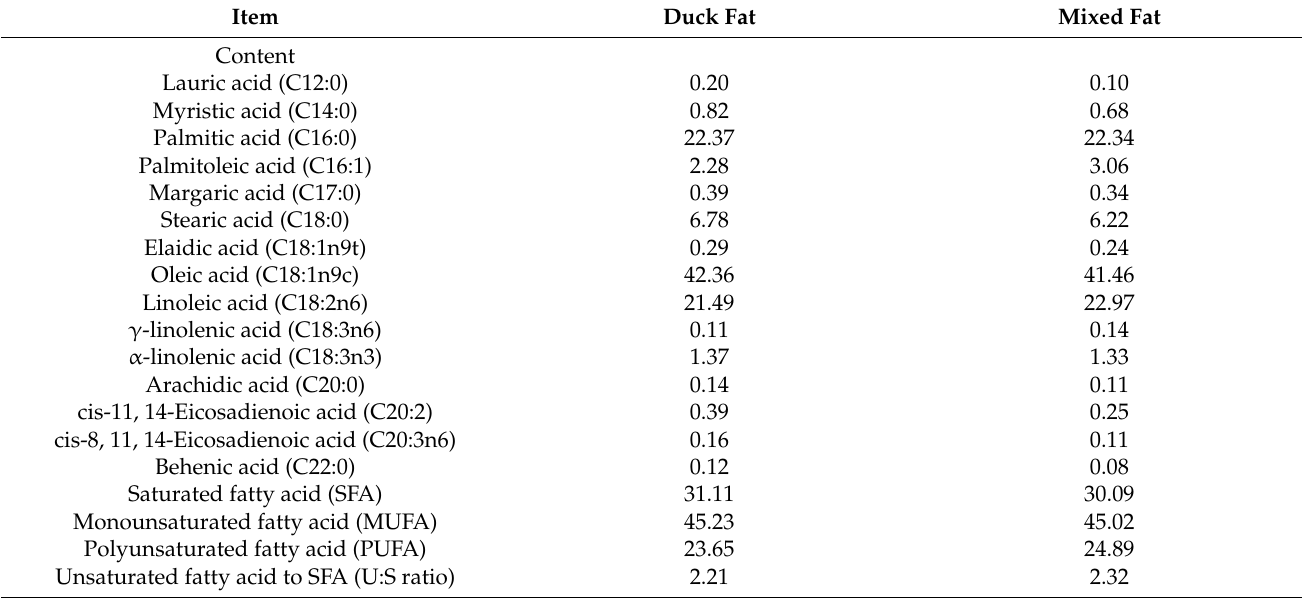
Table 2. Fatty acid profile of duck fat and mixed fat (%) 1,2 . Duck Fat Mixed